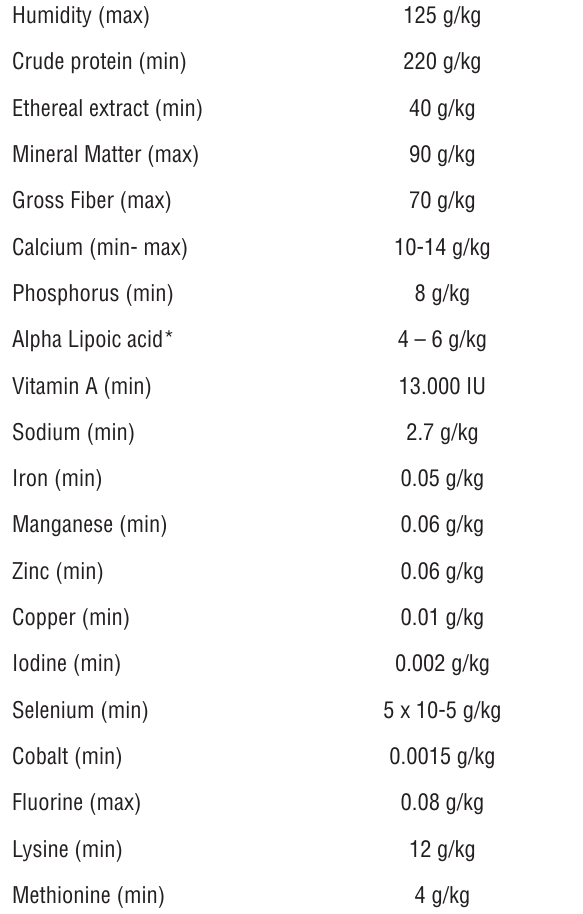
Table 1 - Food composition of experimental